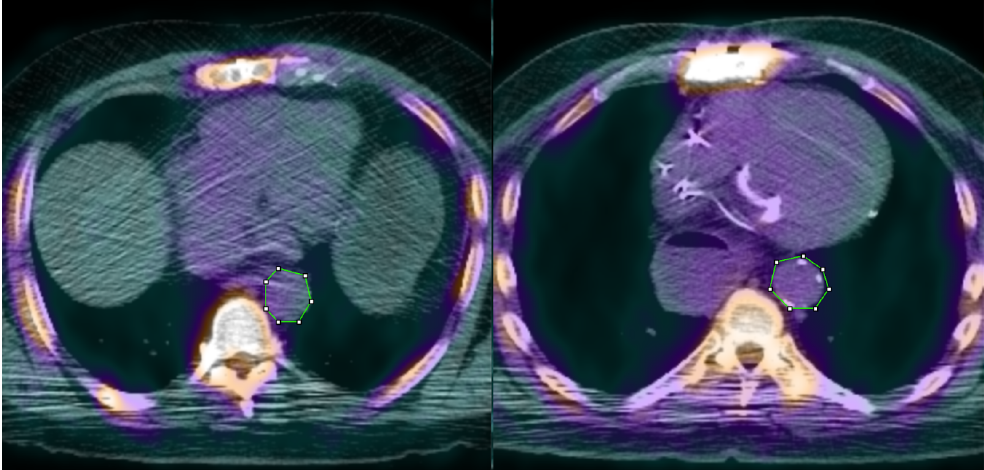
Figure 6. Visual comparison of axial view thoracic aorta 18F-NaF fused PET/CT scans between two study participants controlled for age, weight, height, BMI, and tracer dose. Left : study participant with fewer visible calcifications on CT and lower SUV intensity. Right : study participant with clearly visible aortic calcifications on CT scan and higher SUV intensity. Table 4. Lipid metric comparison between two study participants shown above in Figure 6. Left : study participant with lower atherogenic indices and higher HDL cholesterol. Right : study participant with higher atherogenic indices and lower HDL cholesterol. Left Right 68